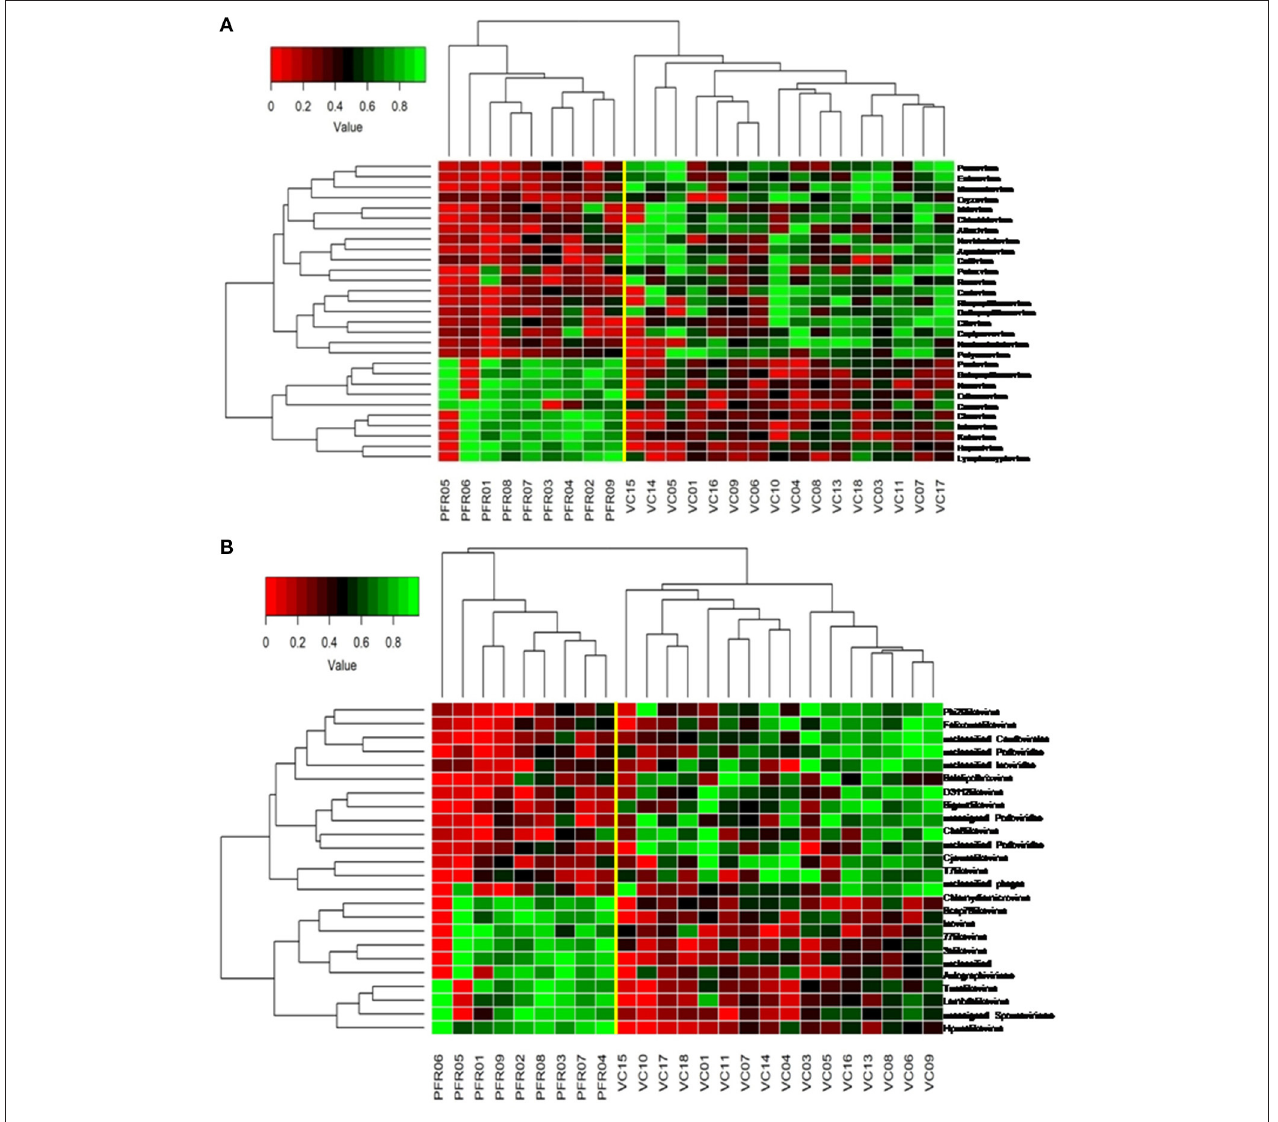
FIGURE 4 | Two-dimensional heat map showing rank normalized abundances (scaled between 0 and 1) in the control group (VC) and post-fever retinitis (PFR) group of eukaryotic viruses (A) and bacteriophages (B) .